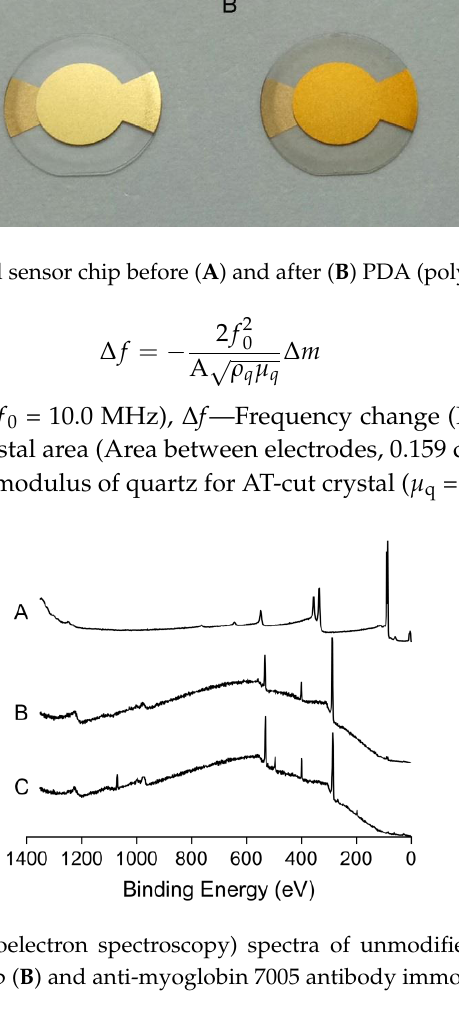
Figure 4. XPS (X-ray photoelectron spectroscopy) spectra of unmodified gold sensor chip ( A ), PDA-coated gold sensor chip ( B ) and anti-myoglobin 7005 antibody immobilized PDA coated gold sensor chip ( C ).